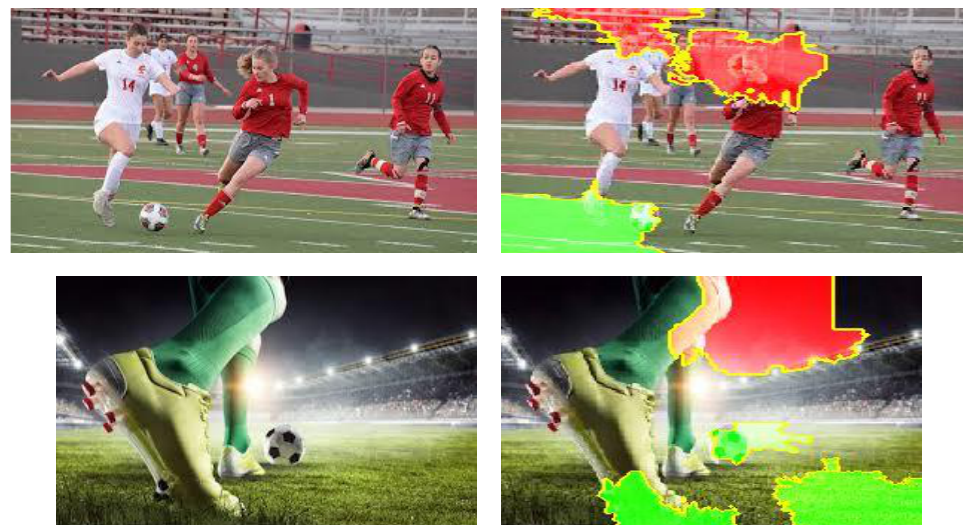
Figure 10. Examples of how LIME explained classifying images as soccer. Here, the shape of the soccer ball or specialties of the soccer shoes are decisive for classification.